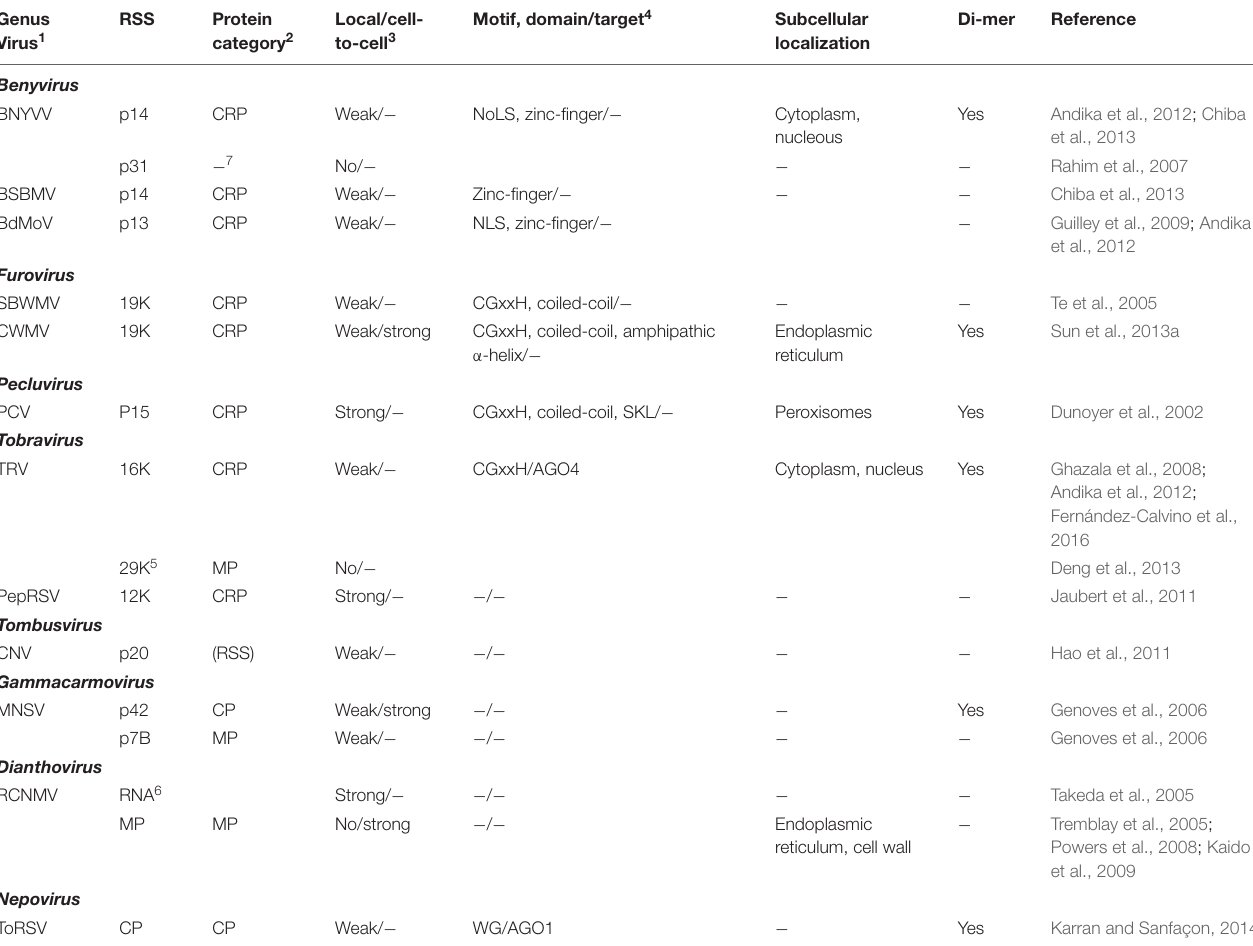
TABLE 1 | Properties of RNA silencing suppressors (RSSs) encoded by soil-borne viruses. Genus Virus